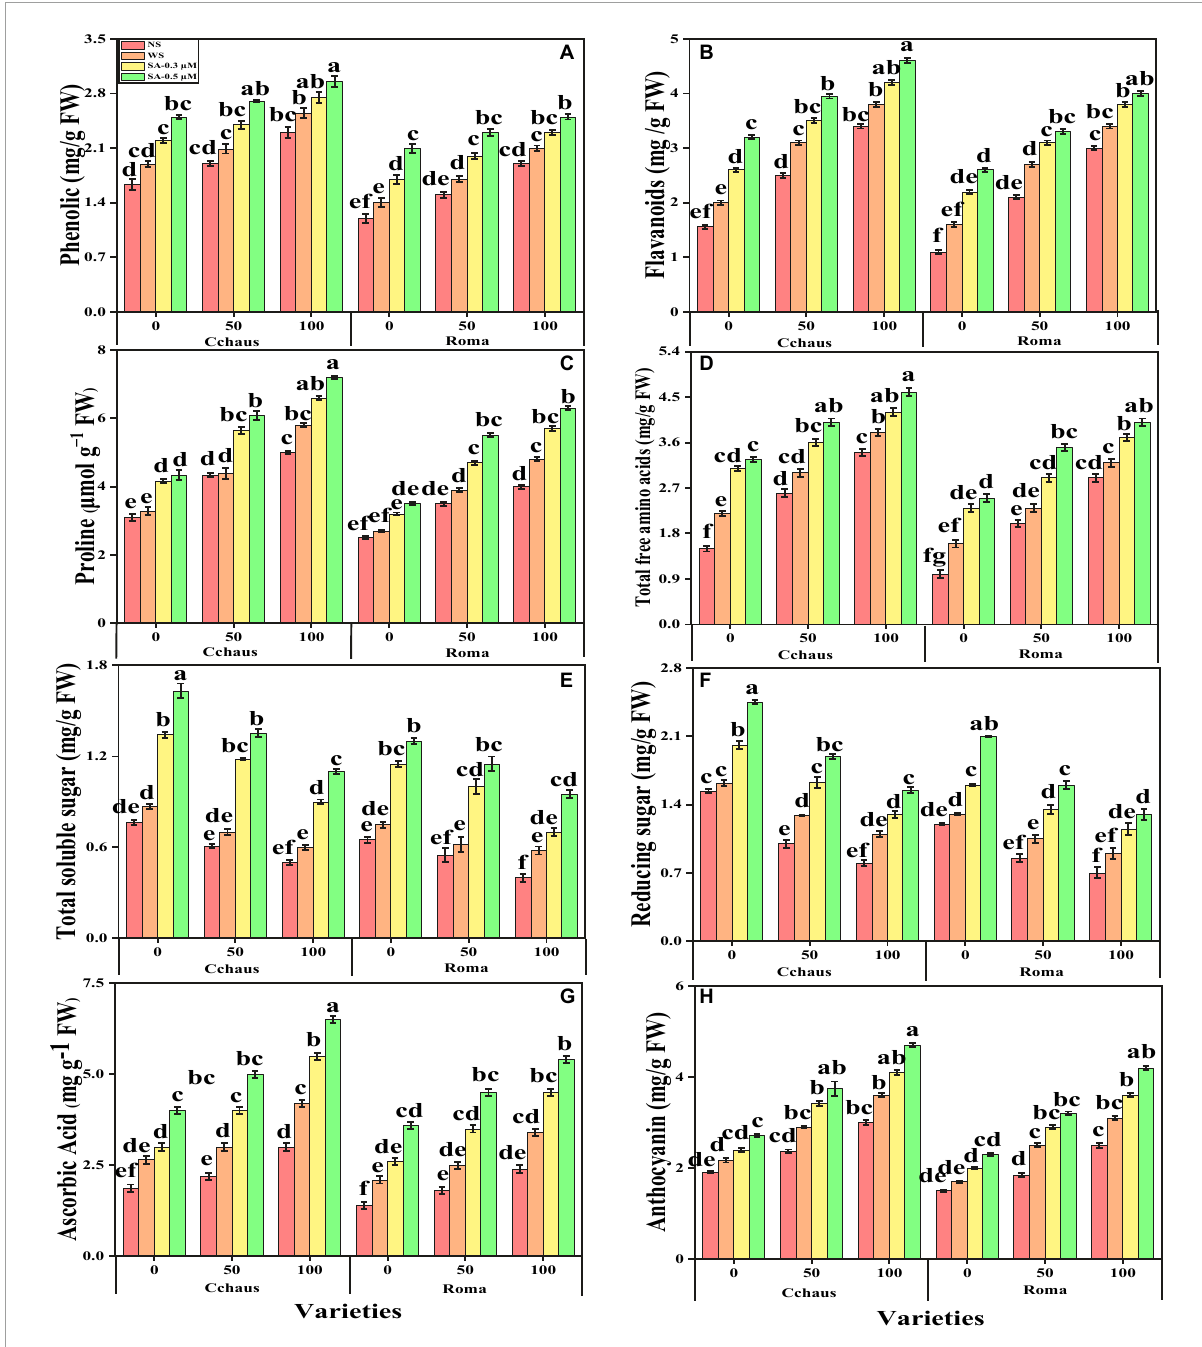
FIGURE5 Effect of exogenously applied syringic acid (0.3-0.5 ◦ µ M) on phenolic contents (A) , flavonoid contents (B) , proline contents (C) , total free amino acids (D) , soluble sugar contents (E) , reducing sugar contents (F) , ascorbic acid contents (G) , and anthocyanin contents (H) on Solanum lycopersicum varieties (Cchaus and Roma) cultivated under stress levels of Pb [0 (no Pb), 50 and 100 mg kg − 1 ]. Values are demonstrated as means of four replicates along with standard deviation (SD; n = 4). Two-way ANOVA was performed and means differences were tested by HSD ( P < 0.05) through Tukey’s test. Different lowercase letters on the error bars indicate significant difference between the